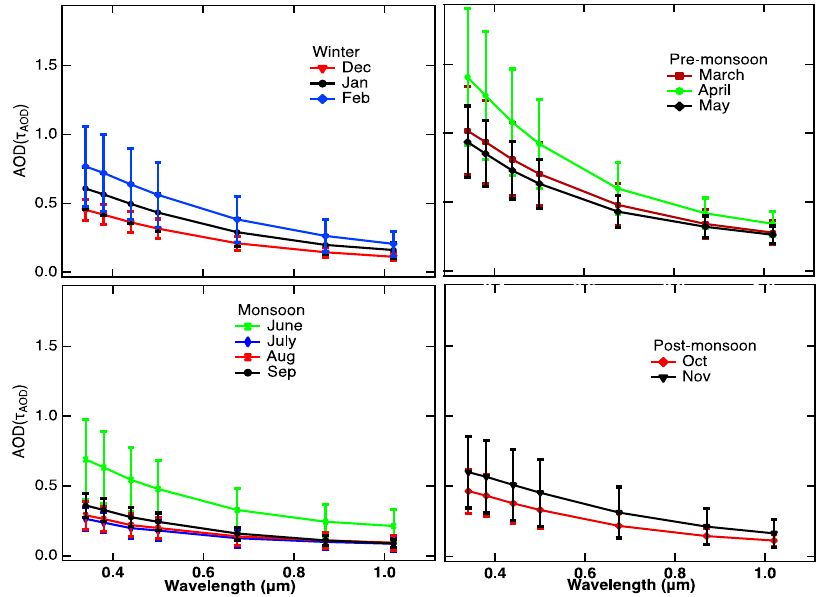
Figure 2. Spectral variation of monthly mean aerosol optical depth (AOD), over nine years between 2010–2018, in different seasons.